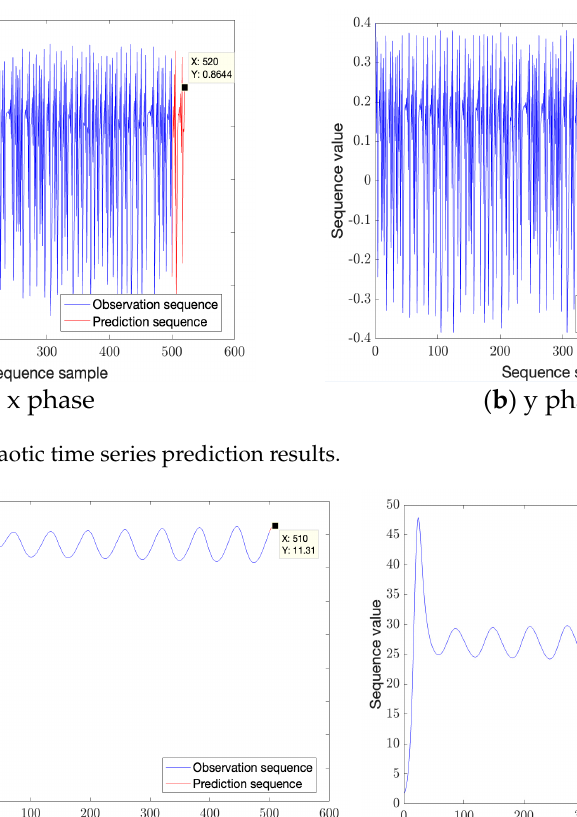
Figure 3. Logistic chaotic time series prediction results.